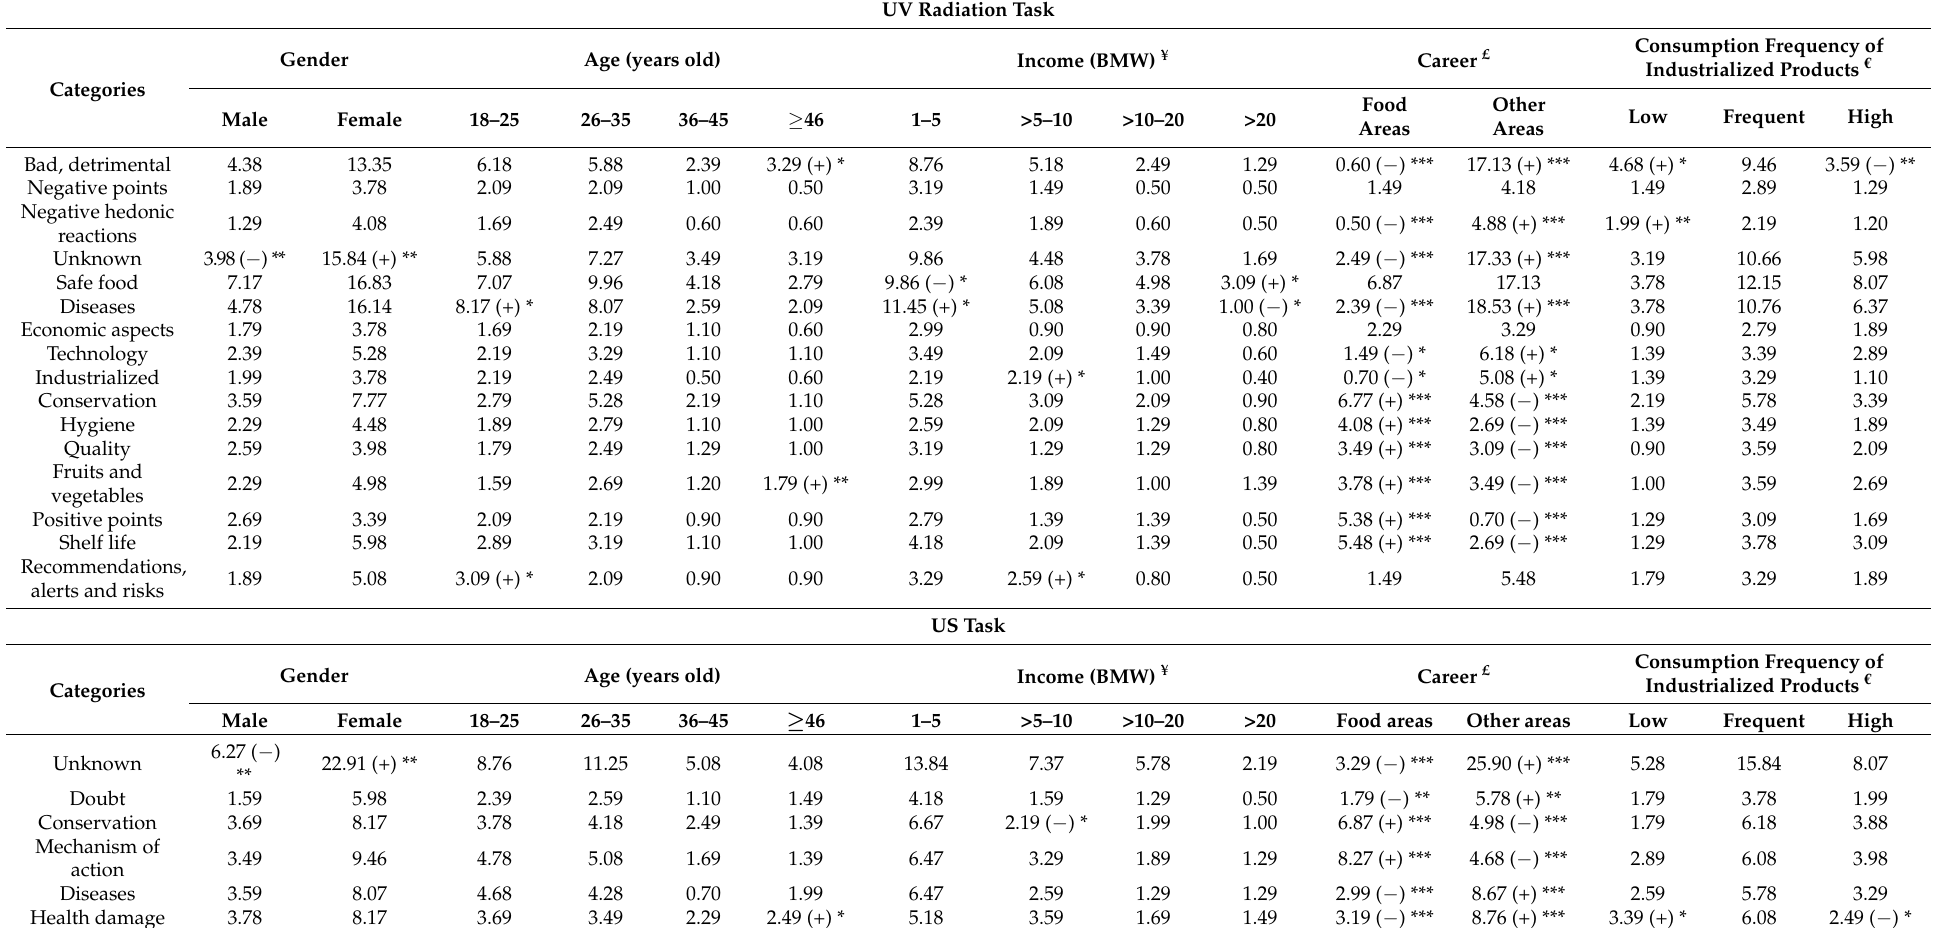
Table 3. Frequency of mention of the categories from ultraviolet (UV) radiation and ultrasound (US) word association tasks according to socioeconomic characteristics (gender, age, income, and career) and consumption frequency of industrialized products of the participants. UV Radiation